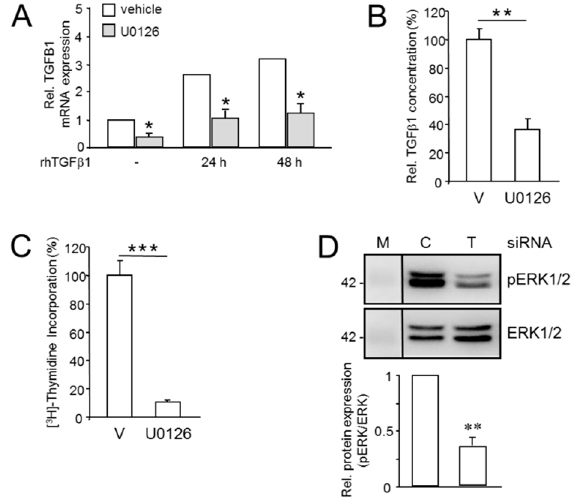
Figure 5. Mutual regulatory interactions between aTGF β 1 and ERK signaling enhances proliferation. ( A ) Panc1 cells were treated, or not (-), for 24 or 48 h with rhTGF β 1 (5 ng/mL) in the absence or presence of U0126 (10 µM) or vehicle (0.1% dimethyl sulfoxide, DMSO) followed by qPCR analysis of TGFB1 and GAPDH and TBP as internal control. Data represent the normalized mean ± SD of triplicate wells from a representative experiment. The asterisks indicate significance relative to the vehicle ctrl. ( B ) As in ( A ), except that cells were switched to serum-reduced medium (0.5% FBS) prior to U0126 treatment. Cells were allowed to condition their growth media for 24 h. Aliquots of conditioned media were subjected to ELISA measurement of total (bioactive + latent) TGF β 1. Data are the mean ± SD of triplicate samples. ( C ) Panc1 cells were treated, or not, for 24 h with U0126 (25 µM) or vehicle (V) followed by ( 3 H)-thymidine incorporation. Data shown are mean ± SD from 6 wells processed in parallel and are representative of 3 experiments. The asterisks indicate significance. ( D ) Panc1 cells were transfected with control or TGFB1 siRNA as described in the legend to Figure 1, 24 h later stimulated with rhTGF β 1 for 1 h and subjected to immunoblotting for phospho-ERK1/2 (pERK1/2), and total ERK1/2 as a loading control. Data represent the mean ± SD from three independent assays. Successful knockdown of TGFB1 was verified by ELISA of secreted TGF β 1. The asterisks ( ∗ ) indicate significant differences relative to the respective controls. *, p < 0.05; **, p < 0.01; ***, p <